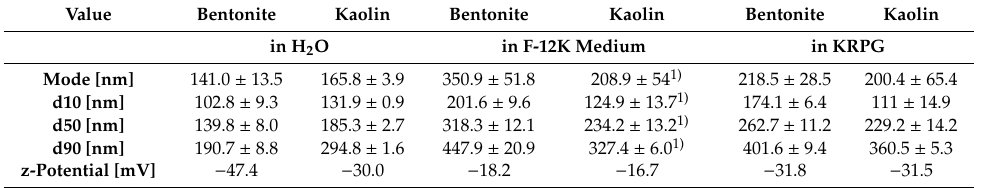
Figure 1. Particle size distribution of kaolin and bentonite particles dispersed in distilled H 2 O as analyzed with optical particle tracking. Kaolin and bentonite were dispersed for 10 and 300 s, respectively (see Method section for details). Table 1. Hydrodynamic particle diameter and z-potential of kaolin and bentonite. Value